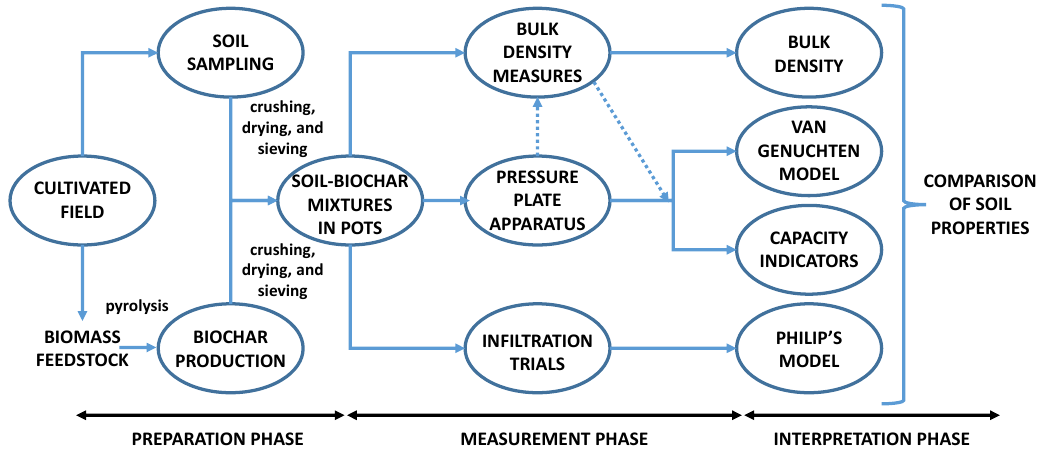
Figure 1. Flow chart summarizing the phases in which the experimental procedure adopted in this work is divided.